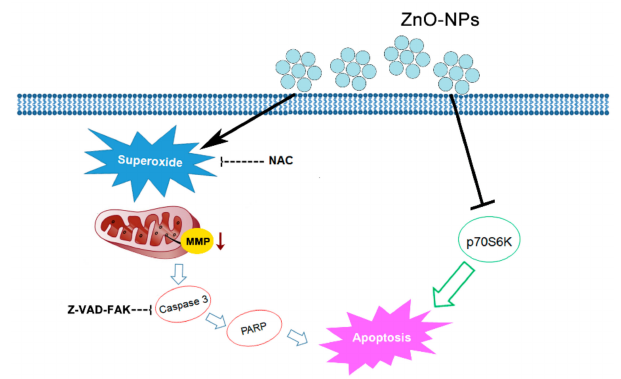
Figure 8. Schematic diagram of ZnO-NP-induced anti-cancer mechanism in human GSCC. Our study data indicate that ZnO-NPs may promote caspase-dependent apoptosis via mechanisms involving both superoxide-mediated mitochondrial intrinsic and p70S6K signaling